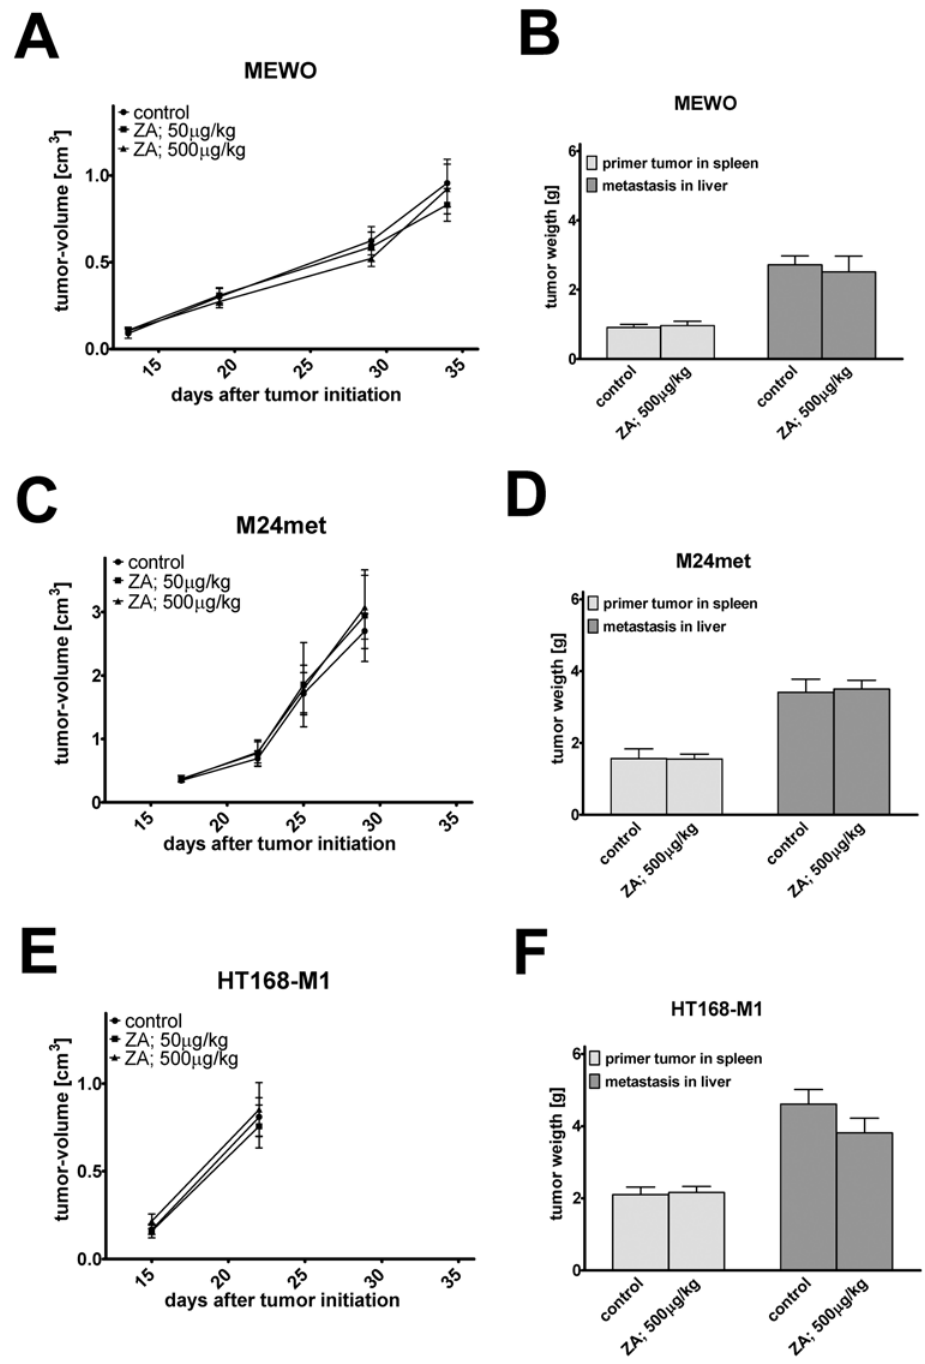
Fig 6. In vivo effects of zoledronic acid treatment. Effect of zoledronic acid (ZA) treatment using in vivo subcutaneous xenograft model of human melanoma cells in SCID mice ( A, C, E ). ZA treatment failed to show effects in the subcutaneous growth of melanoma cells with either mutation. ( B, D, F ) Effect of ZA treatment using in vivo spleen liver colonization model of human melanoma cells in SCID mice. ZA did not inhibit the primary tumor or metastatic growth of melanoma cells. Data shown as average ±